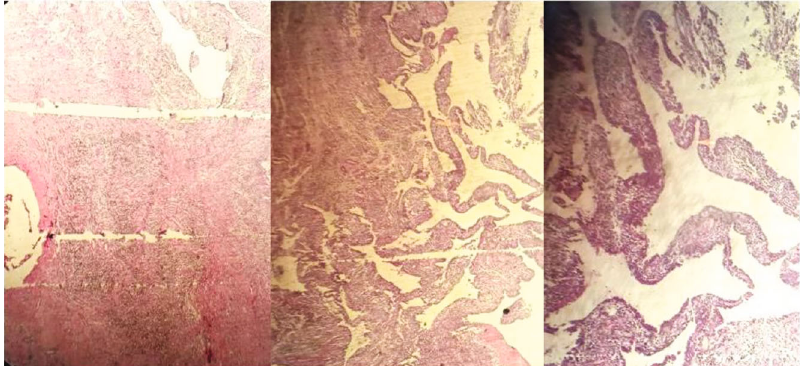
Figure 4: Histopathology appearance of TGCT shows di ff use-type intra-articular lesion, which indicates hemosiderin deposition and villonodular protrusions with overlying synovial tissue; mononuclear histiocytoid cells which interacted with osteoclast-like multinucleated giant cells are also noted.